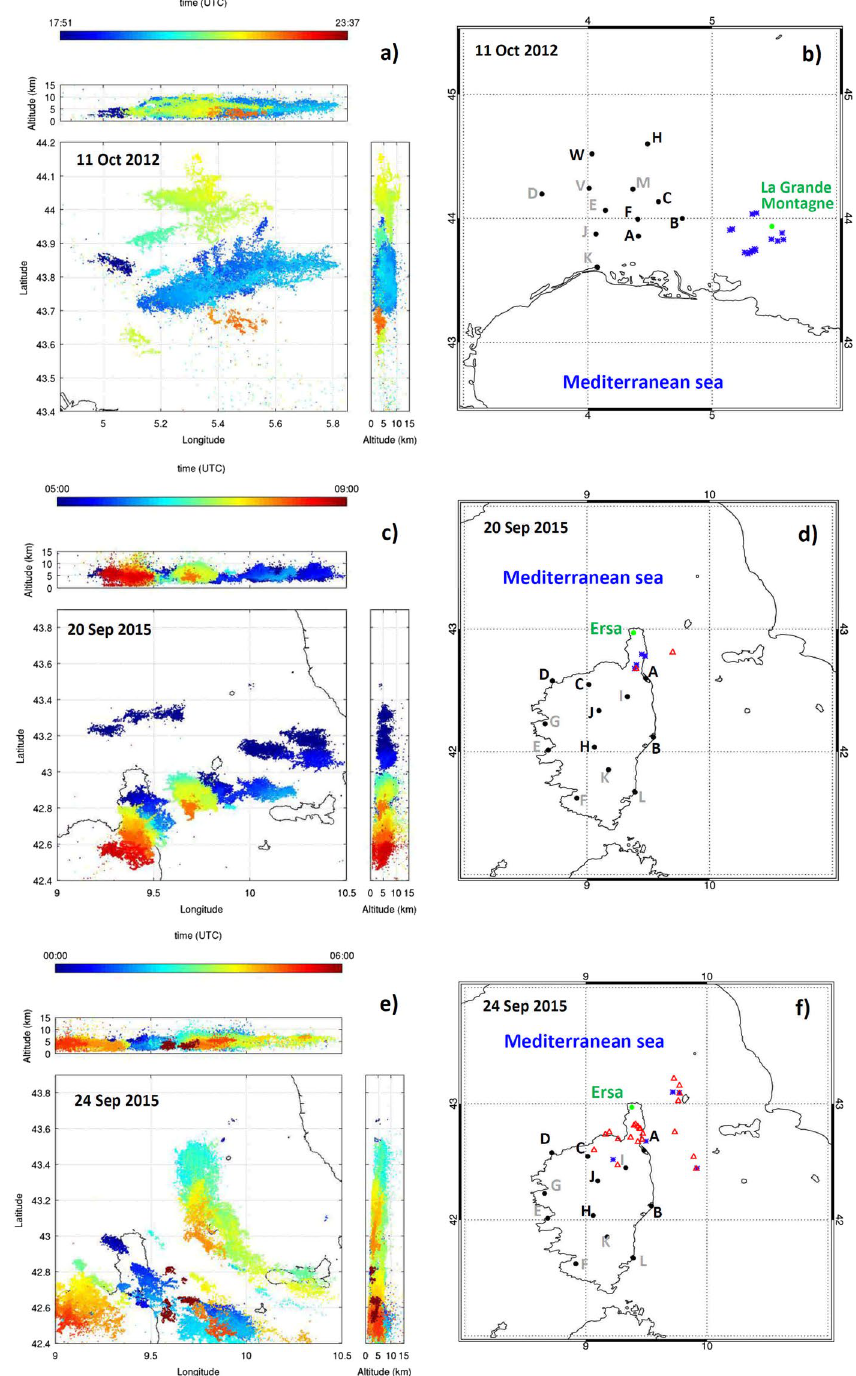
Figure 1. Maps. ( a ) VHF radiation sources geo-located by HyLMA on 11 October 2012. ( c,e ) VHF radiation sources geo-located by SAETTA on 20 September 2015 and 24 September 2015, respectively. Color represents the time of observation of each source. ( b ) Configuration of instruments used in 2012. ( d,f ) Configuration of instruments used in 2015. Green dots represent locations of broadband magnetic-field receivers, black dots show positions of LMA stations, blue stars and red triangles respectively represent negative cloud-to-ground and intracloud discharges identified by Météorage (no positive cloud-to-ground lightning was detected). The LMA stations used for our study are labeled by dark letters. Maps have been plotted using the Interactive Data Language ver.